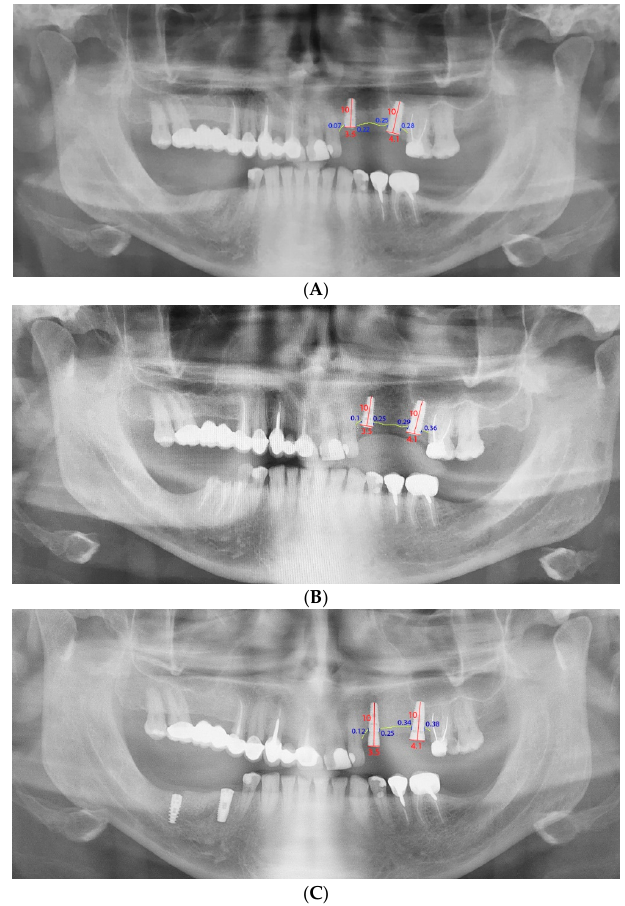
Figure 2. Measurement of periimplant bone loss. ( A ) After implant placement; ( B ) after 1 month; ( C ) after 4 months.